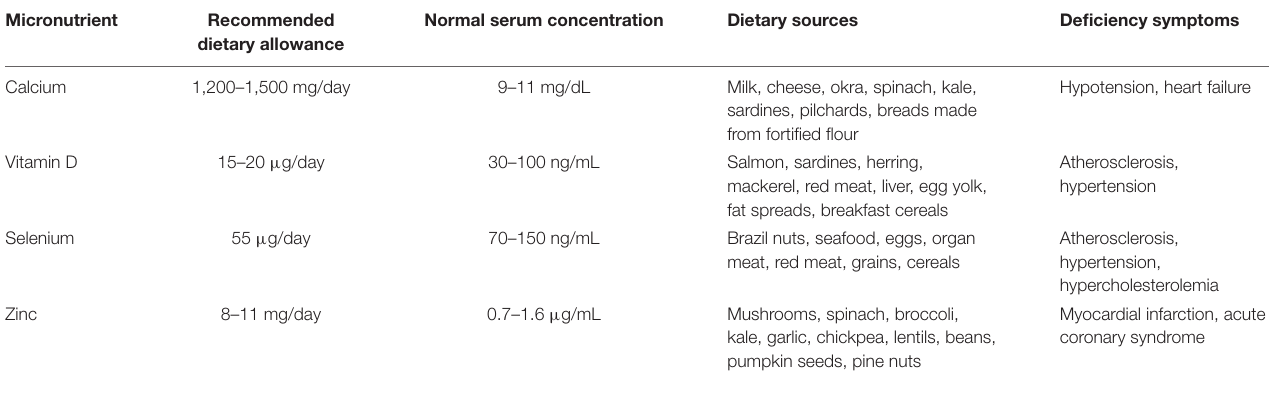
TABLE 1 | Recommended dietary allowance, normal serum concentration, dietary sources, and deficiency symptoms of calcium, Vitamin D, selenium, and zinc.